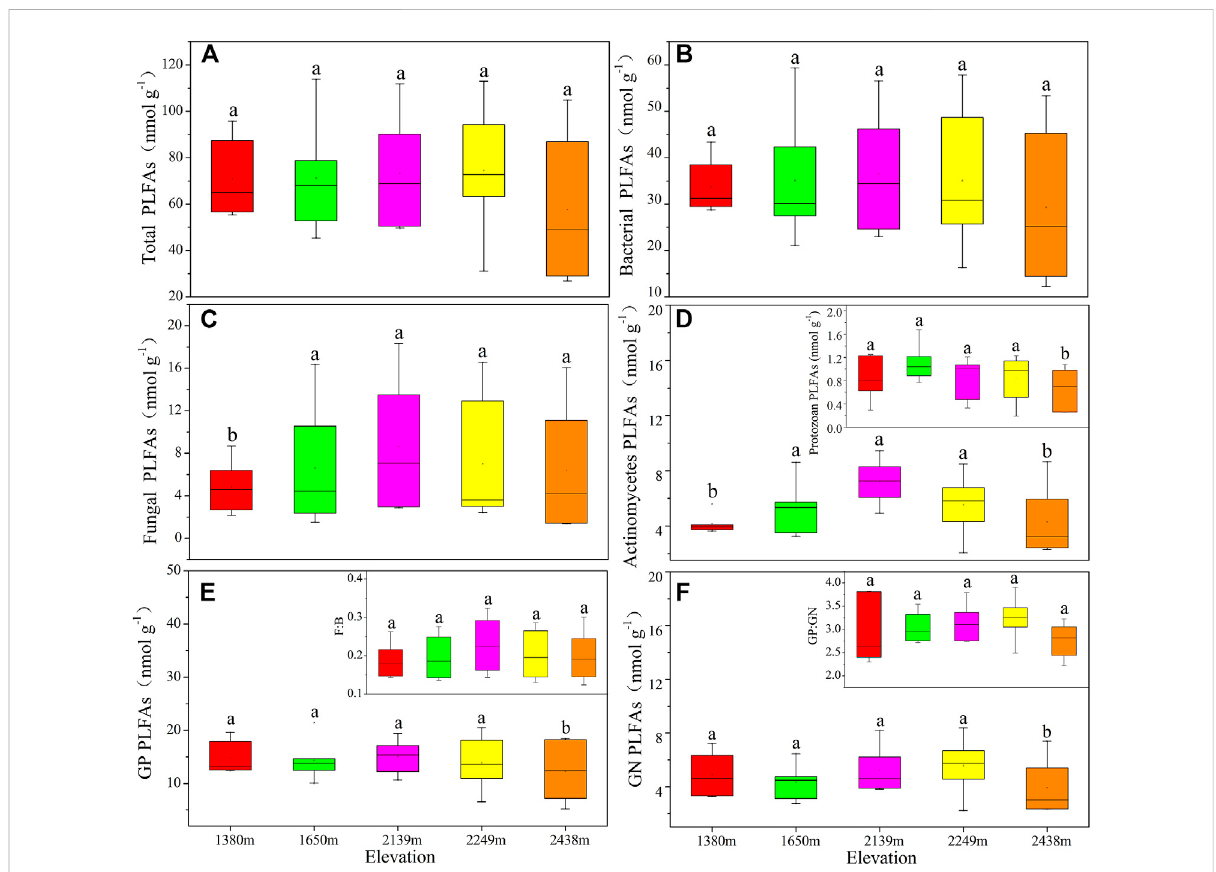
FIGURE 1 ThesoilcommunitycomponentsbasedonPLFApro fi lingatdifferentaltitudegradients.Differentsmalllettersindicatesigni fi cantdifference( p < 0.05)amongdifferentaltitudes( n = 6).The same below. F:B: theratio of fungi to bacteria; GP: gram-positivebacterial;GN: gram-negative bacterial; GP: GN: gram-positive bacteria to Gram-negative bacteria ratio. Total PLFAs (A) , bacterial PLFAs (B) , fungal PLFAs (C) , actinomycetes and protozoa PLFAs (D) , GP PLFAs and F:B (E) , GN PLFAs and GP:GN (F)